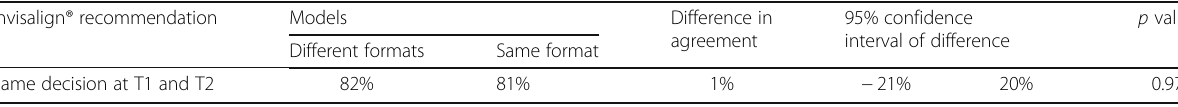
Table 4 Intra-rater agreement when viewing the case twice Invisalign® recommendation